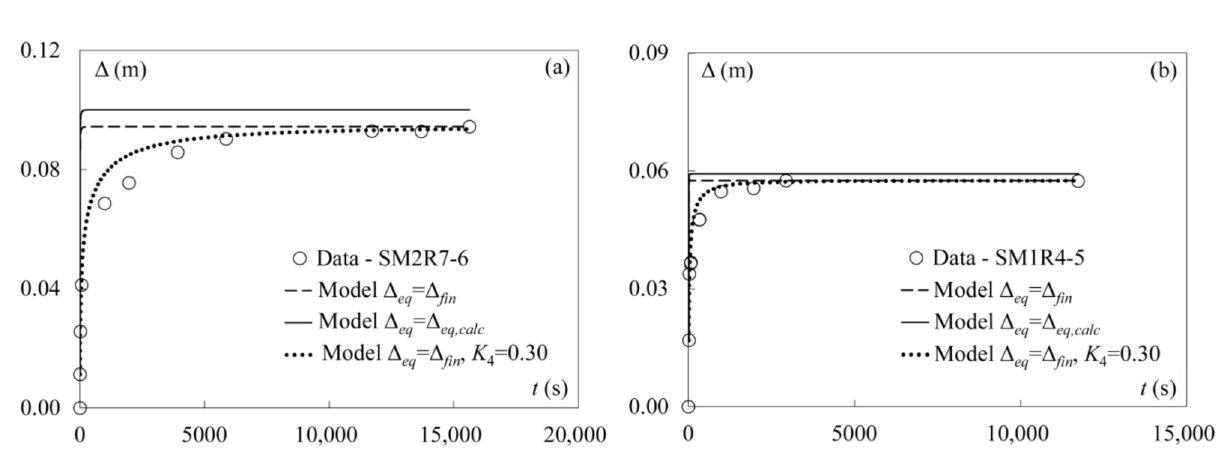
Figure 9. Comparison of numerical solutions of Equation (5) with experimental data pertaining to: ( a ) test SM2R7-6 and ( b ) test SM1R4-5 of Lu et al. [25]. Numerical solutions were obtained assuming ∆ eq = ∆ fin (dashed line), ∆ eq = ∆ eq,calc (continuous line), ∆ eq = ∆ fin and K 4 = 0.3 (dotted